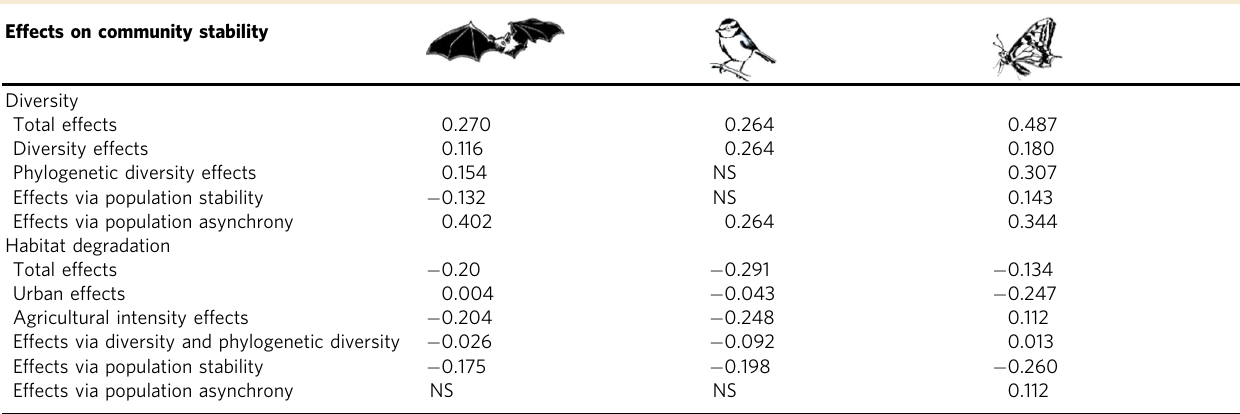
Table 1 Strength of the different paths by which diversity and habitat degradation affect the stability of bat, bird, and butter fl y local